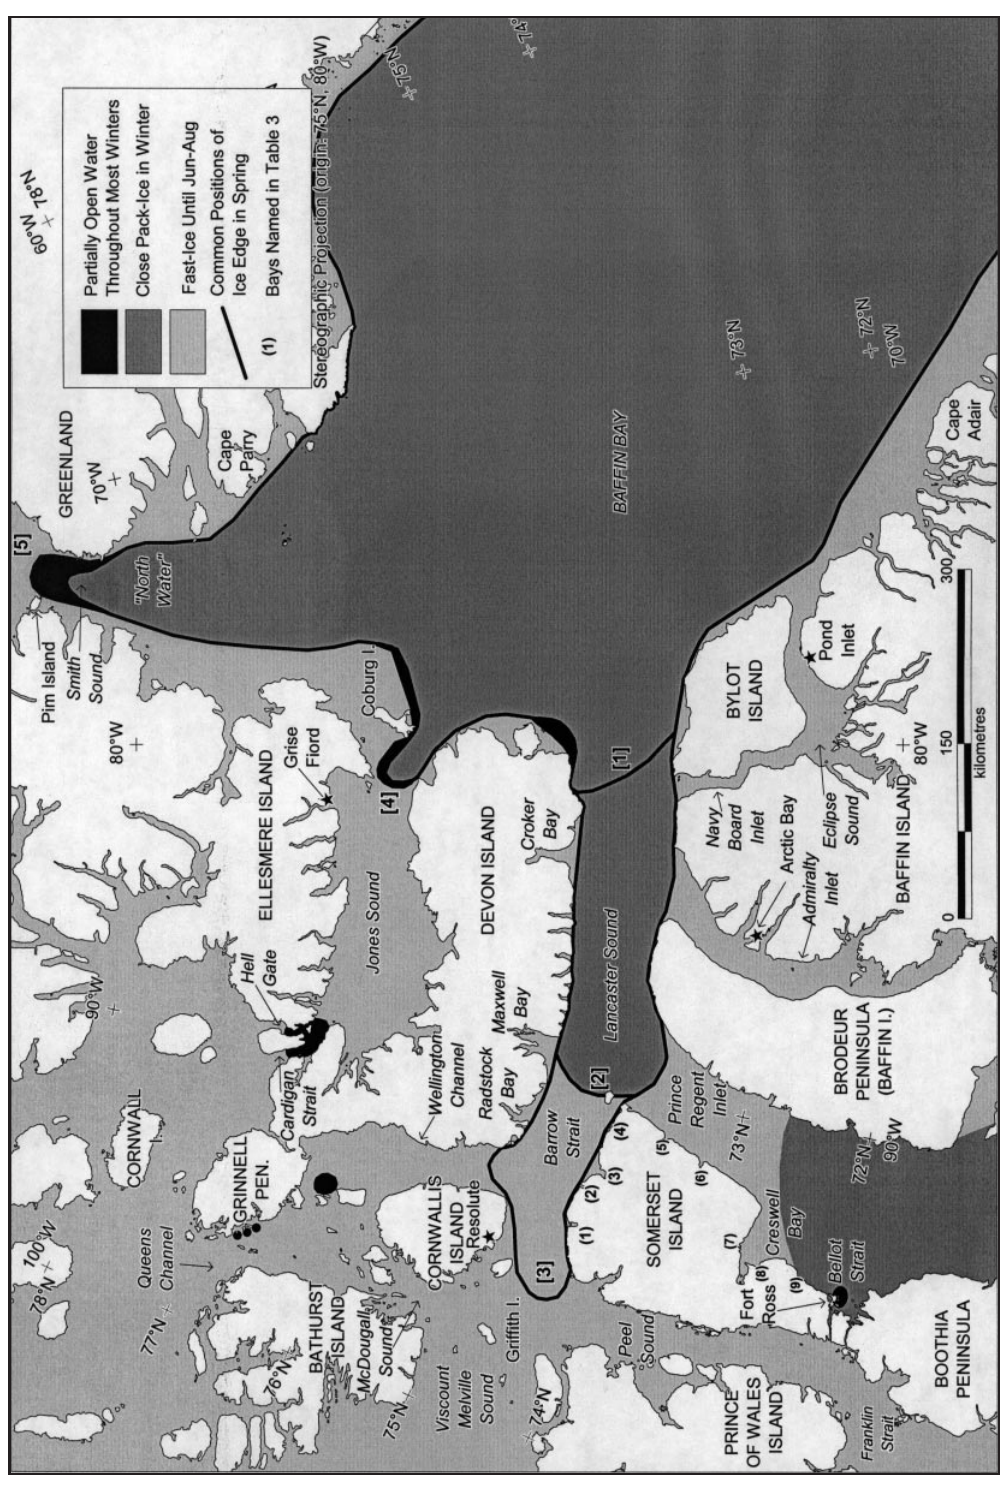
Fig. 3 . Major ice characteristics within the study